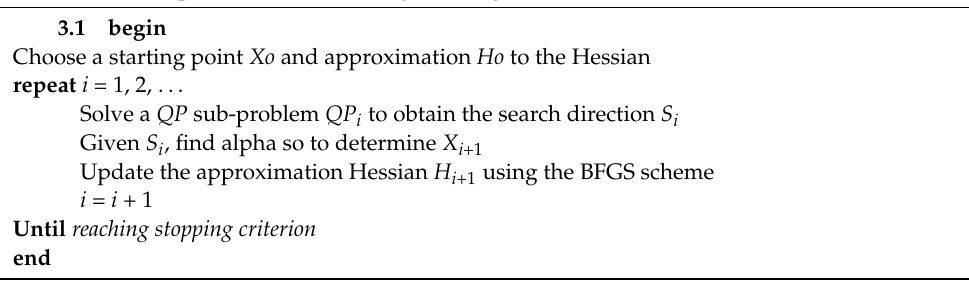
Algorithm 2. Sequential Quadratic